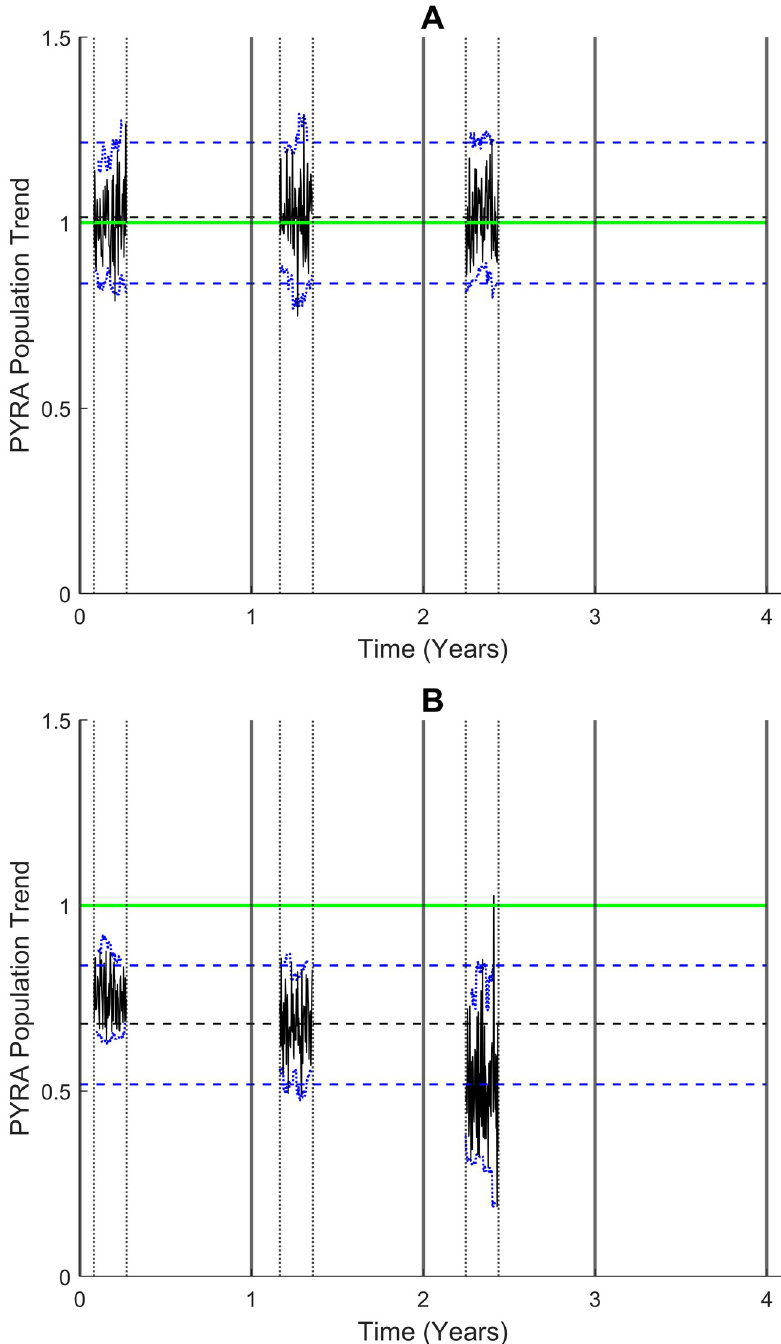
Fig 4. The PYRA statistical estimator b P ð t � Þ (solid black) for the paired data sets plotted against time with 95% percentile lower (L) and upper (U) confidence limits (dotted blue) computed with a sliding bootstrap window of width w = 21 days (3 weeks) for (A) Scenario 1 and (B) Scenario 2. The respective trend mean averages ½ b P g t � ð Þ� ¼ b P total time span T of the data set are superimposed (dashed black) together with 95% percentile confidence limits (dashed blue). The baseline ‘no trend’ PYRA value of 1 is the horizontal green line. In (A) the trend statistic c P 1 : 006 (L = 0.947, U = 1.013) indicates the trend is flat; in (B) c P trend, estimated at 33% [(1–0.676) x 100%] over the time span T of the data set.